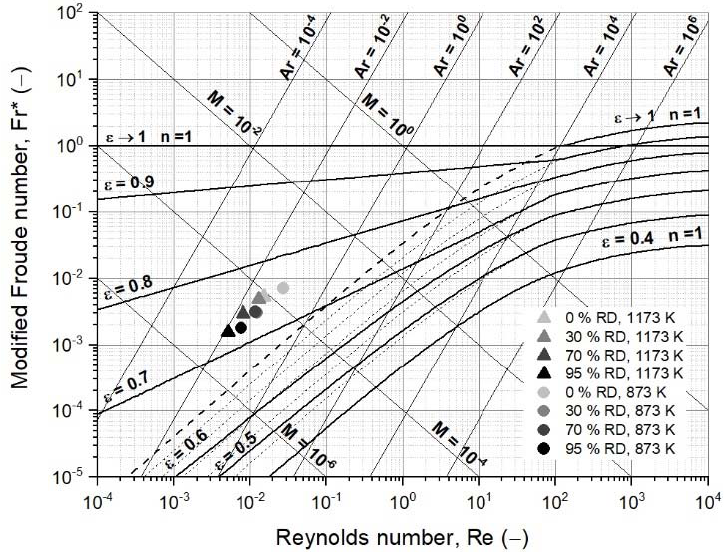
Figure 6. Extended fluidized state diagram following Reh’s approach, including process data [48].